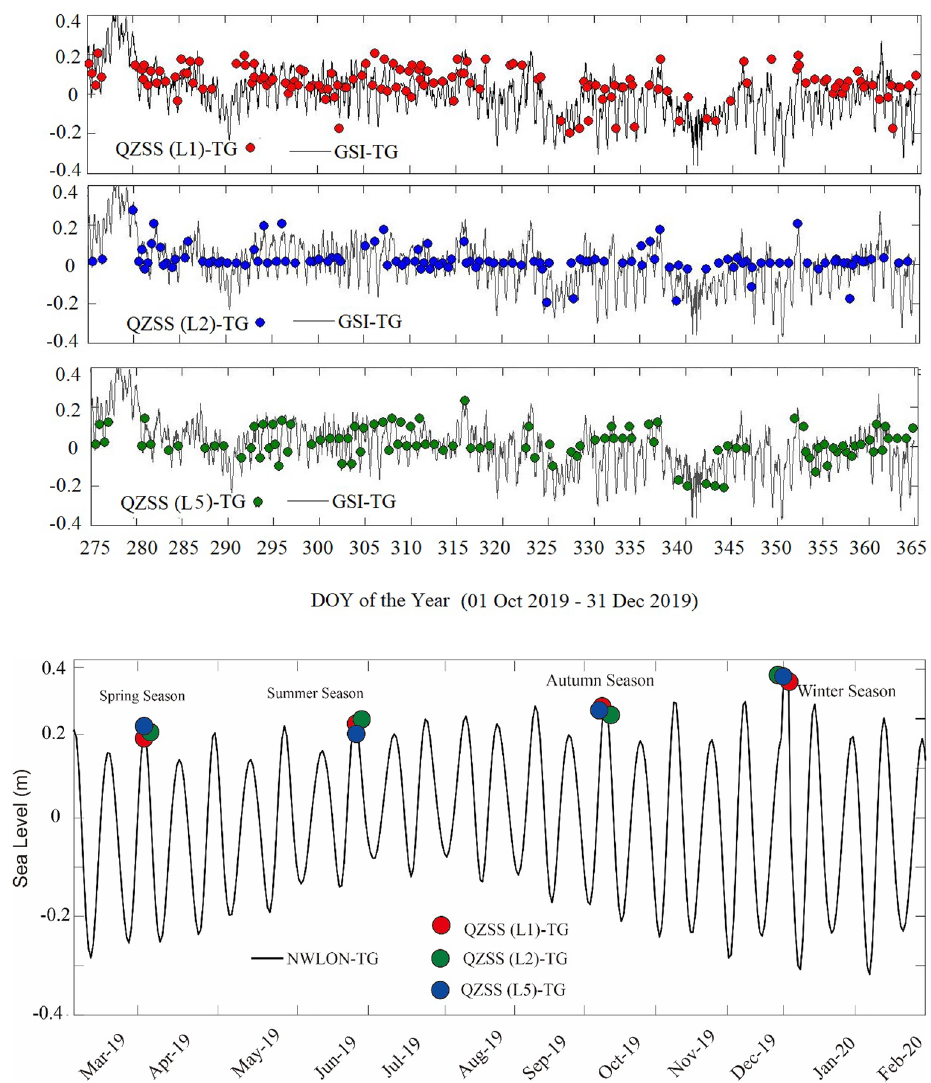
Figure 6. Daily sea-level changes (unit: m) obtained from QZSS L1, L2 and L5 SNR observations (namely, QZSS-TG) as well as GSI tide gauge (namely, GSI-TG) observations during 01 October 2019 to 31 December 2019 (90